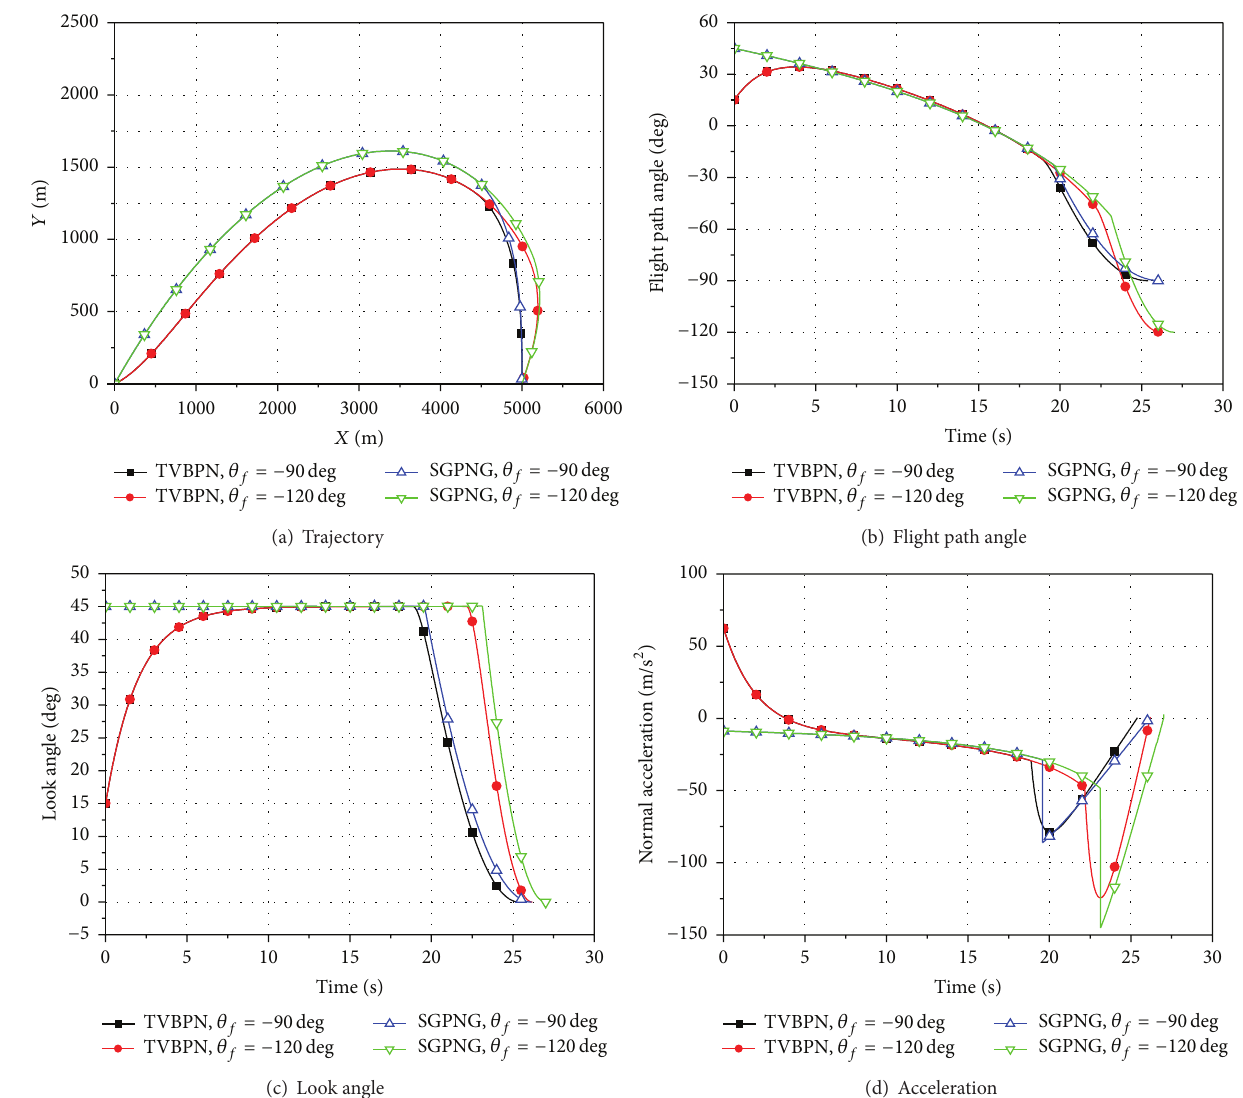
Figure 4: Comparison results for constant speed missile